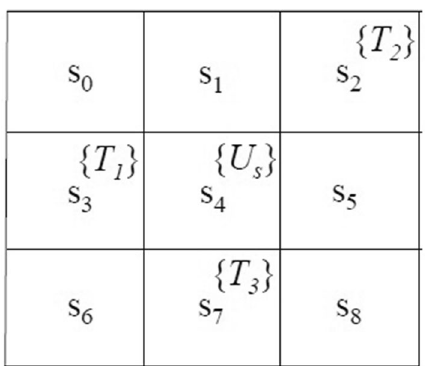
Figure 2. A grid-world with states of interest labeled by T i and unsafe states labeled by U s